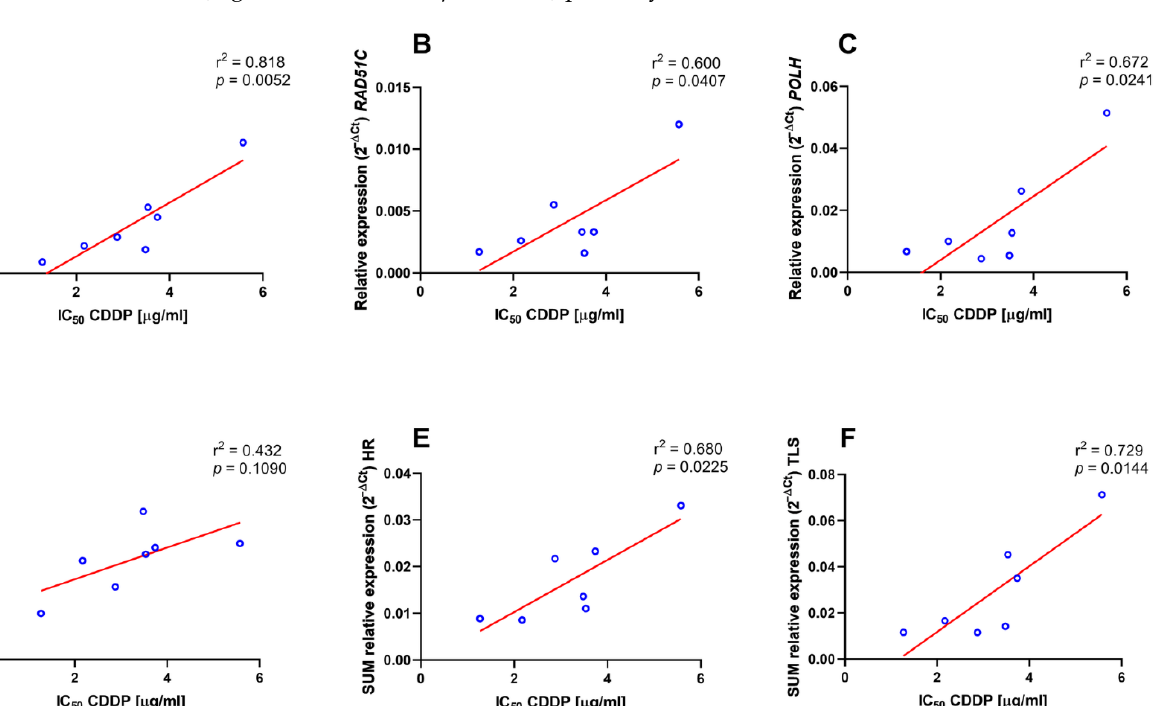
(Figure 7C; r 2 ꞊ 0.672, p ꞊ 0.0241 and Supplementary Figure S2F,G) mRNA levels. Although not with NER (Figure 7D; r 2 ꞊ 0.432, p ꞊ 0.109), IC 50 values also significantly correlated with the cumulative basal expression of the HR (Figure 7E; r 2 ꞊ 0.680, p ꞊ 0.0225) and TLS (Figure 7F; r 2 ꞊ 0.729; p ꞊ 0.0144) pathways. (Figure 7F; r 2 = 0.729; p = 0.0144) pathways.